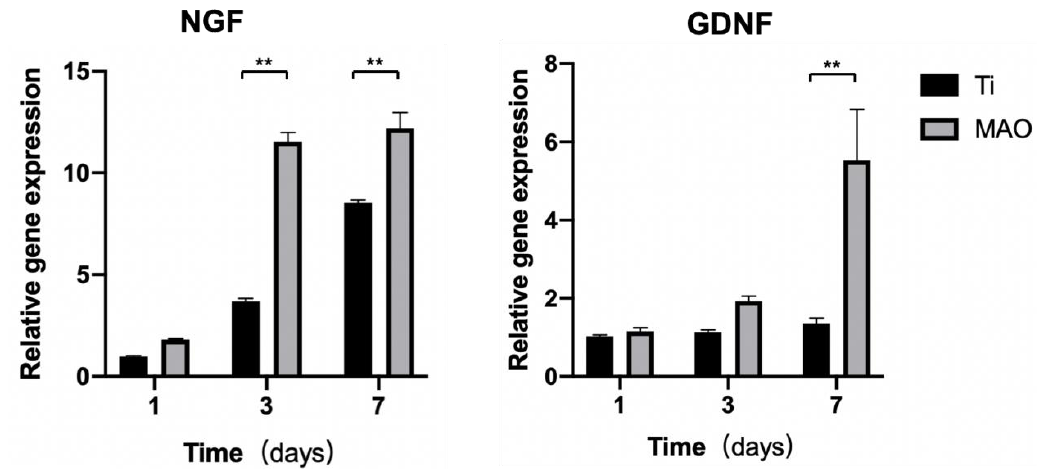
Figure 5. Gene expression level of Ngf and Gdnf in Schwann cells on days 1, 3 and 7 by real-time PCR (mean ± SD, n = 6). The mRNA expression of Ngf and Gdnf was up-regulated in both groups from day 1 to day 7. On the third and seventh days, the gene expression of Ngf in the MAO group was significantly higher than that in the Ti group. On the seventh day, the MAO group appeared significantly up-regulated in the gene expression level of Gdnf . (“**” means p < 0.01).